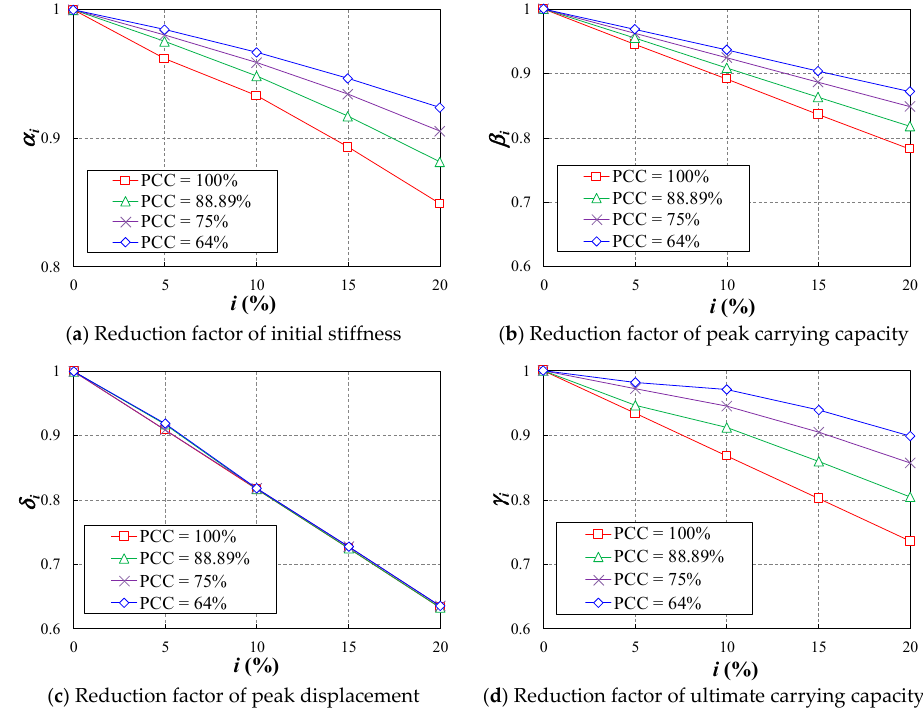
Figure 10. Reduction factors of building interstory backbone curve parameters: ( a ) Reduction factor of initial stiffness; ( b ) Reduction factor of peak carrying capacity; ( c ) Reduction factor of peak displacement; ( d ) Reduction factor of ultimate carrying capacity.